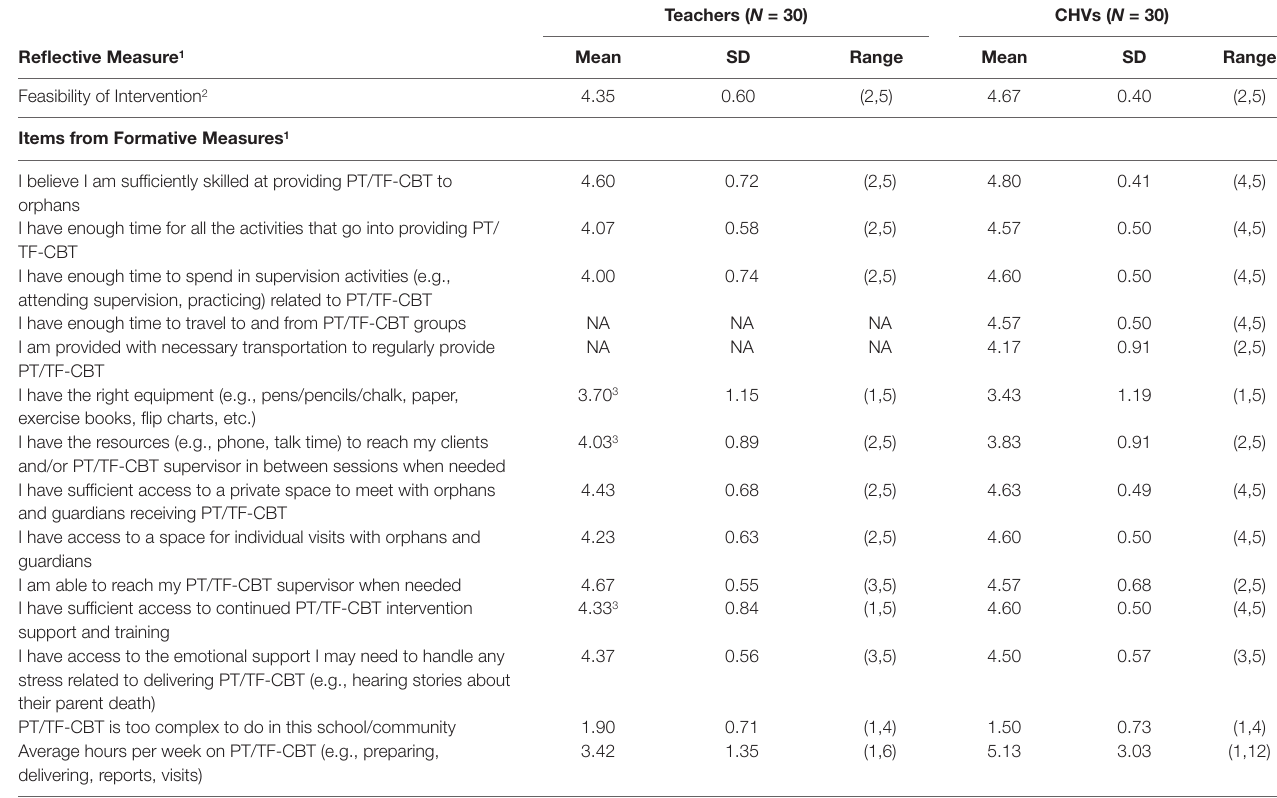
TaBLE 3 | Reflective and Formative Measures of Feasibility among Teachers and CHVs at